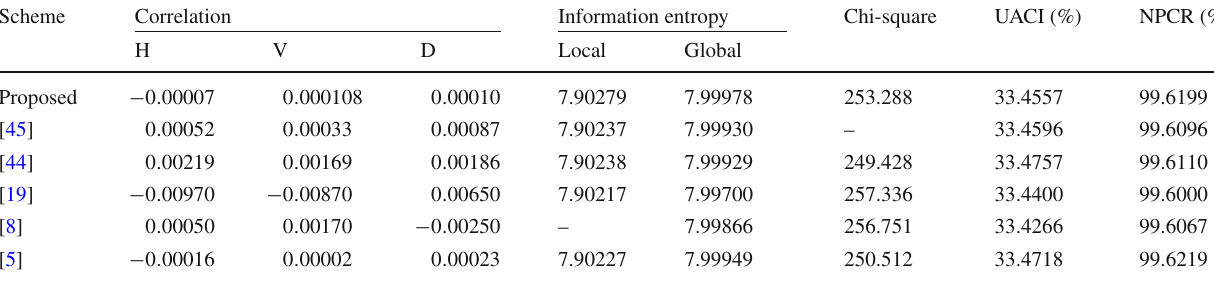
Table 7 Comparison of the suggested scheme with other related approaches Scheme Correlation Information entropy Chi-square UACI (%) NPCR (%) H V D Local Global Proposed − 0 . 00007 0 .